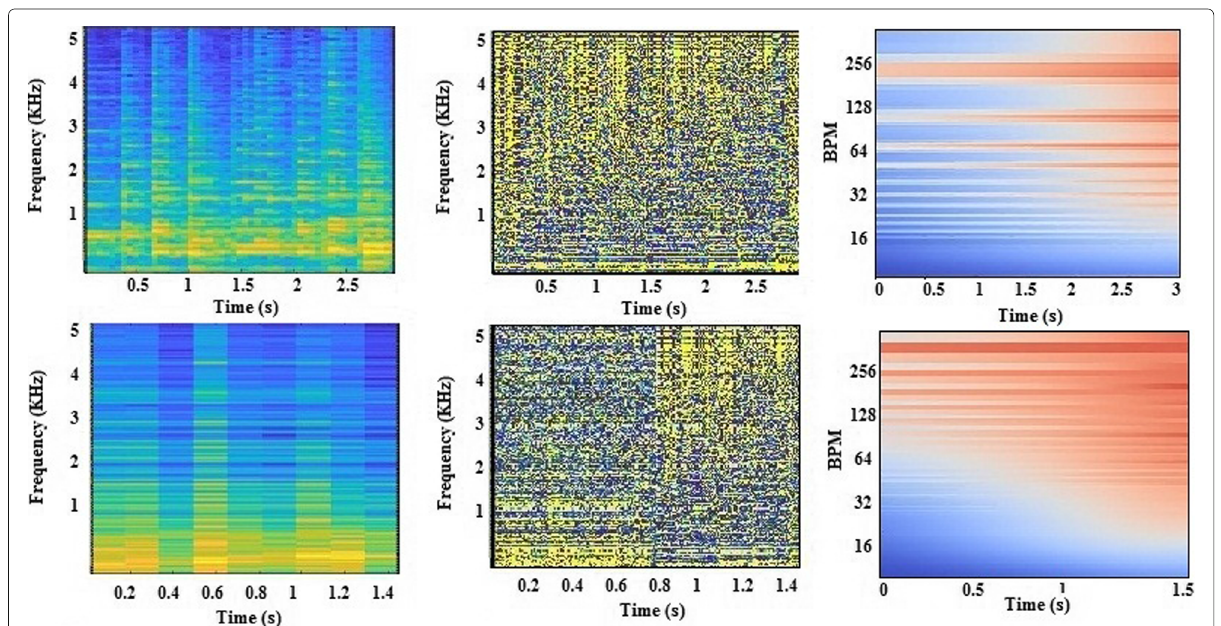
Fig. 1 Visual representation of an audio excerpt with acoustic guitar as leading, Upper pane represents the Mel-spectrogram, modgdgram, and tempogram of the original audio file and lower pane represents the WaveGAN generated